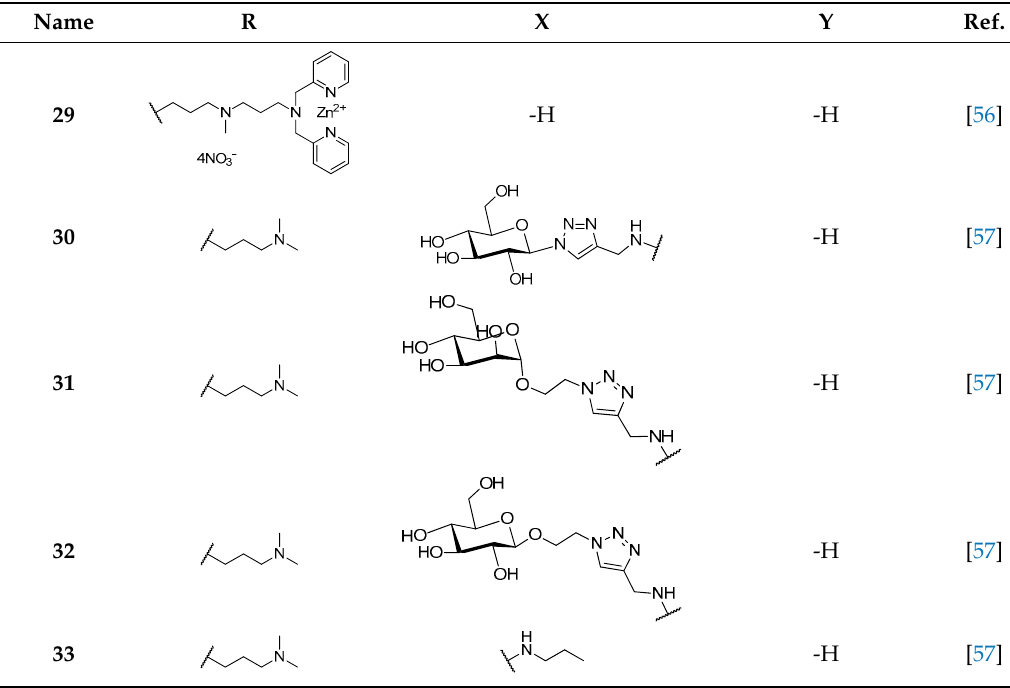
Table 1. Cont . Table 1. Structures of NDIs used as reversible ligands to stabilize telomeric G4s.